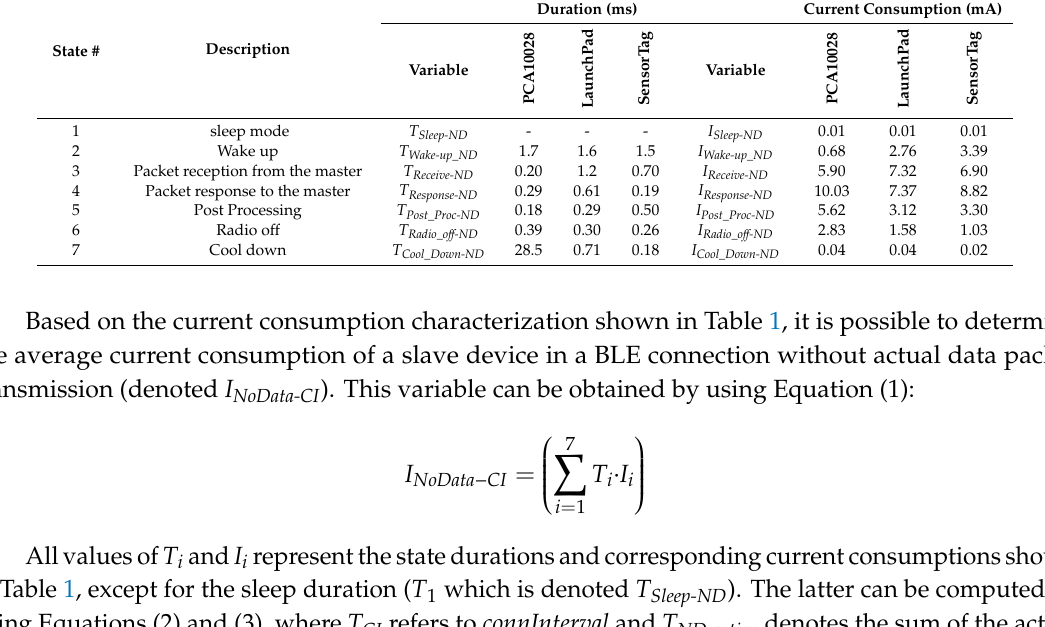
Figure 10. Current consumption of the active part of a connection interval without data transmission: ( a ) PCA10028; ( b ) LaunchPad; ( c ) SensorTag.